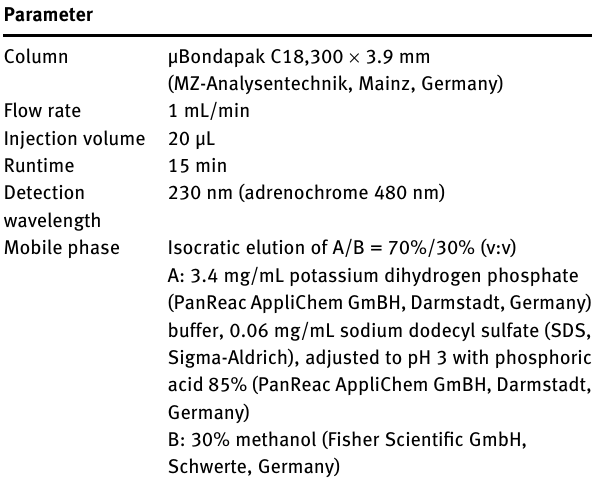
Table  : Characteristics of the RP-HPLC assay for quantitative analysis of E  .  mg/mL injection